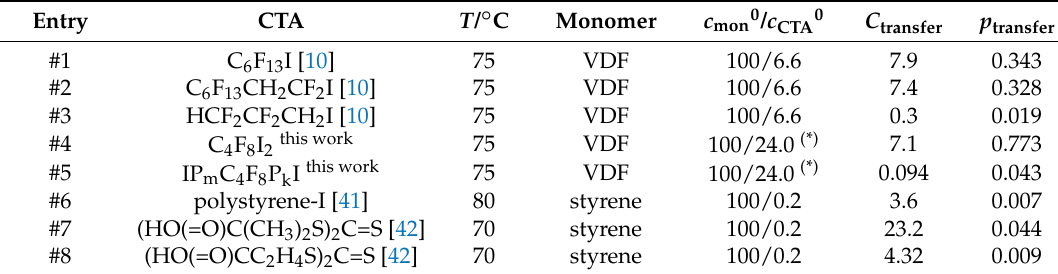
Table 3. Comparison of transfer constants, C transfer , and transfer probabilities, p transfer , for ITP and RAFT polymerizations; CTA: chain transfer agent; T : temperature; 0 refers to initial